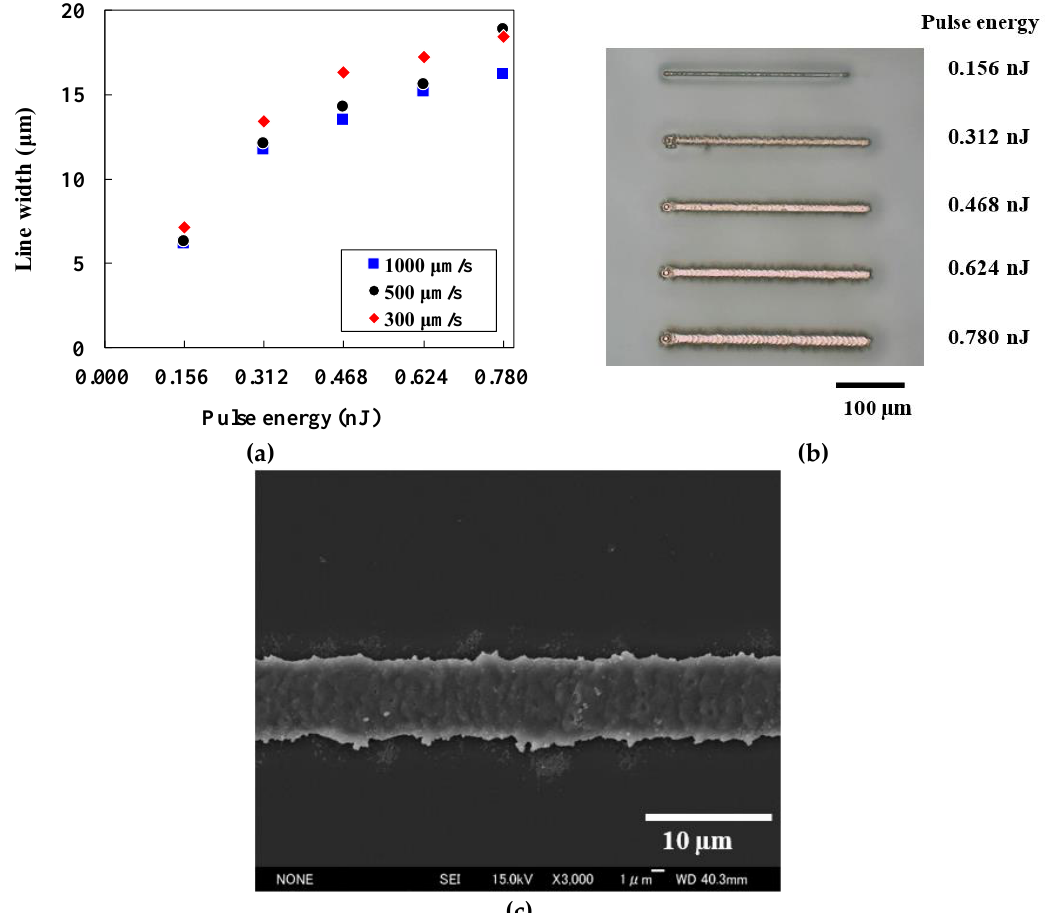
Figure 3. ( a ) Relationship between line width and laser irradiation conditions, ( b ) optical microscope image at scanning speed of 1000 µm/s and various pulse energies, and ( c ) field-emission scanning electron microscopy (FE-SEM) image showing the line width obtained when using a pulse energy of 0.156 nJ and scanning speed of 500 µm/s.